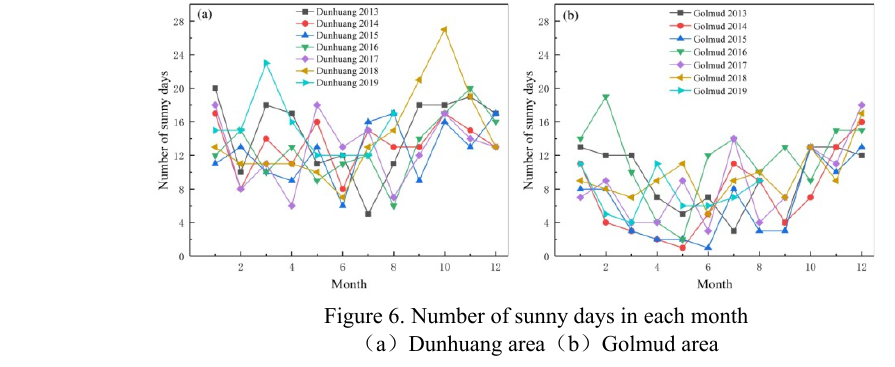
Figure 6. Number of sunny days in each month